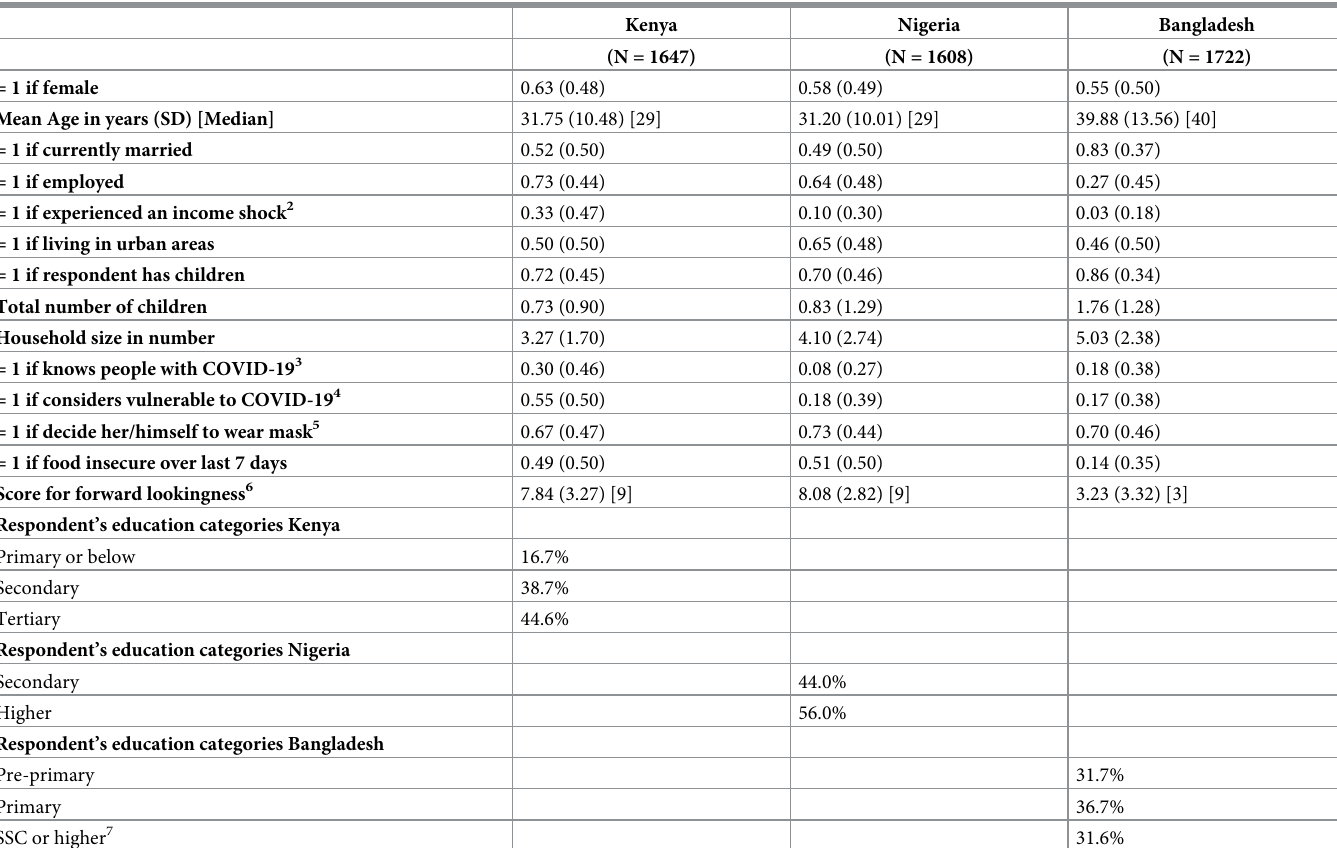
Table 1. Demographic and socioeconomic characteristics of respondents in the first survey round in all 3 countries 1